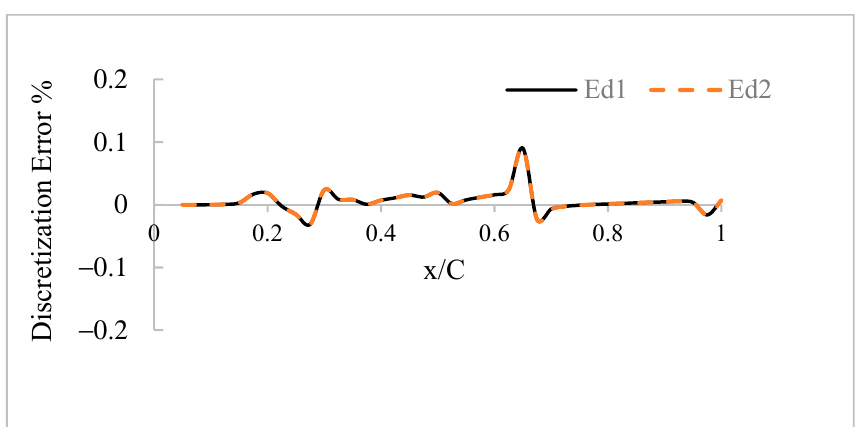
Figure 4. Discretization error comparison between three meshes and two levels of refinement.